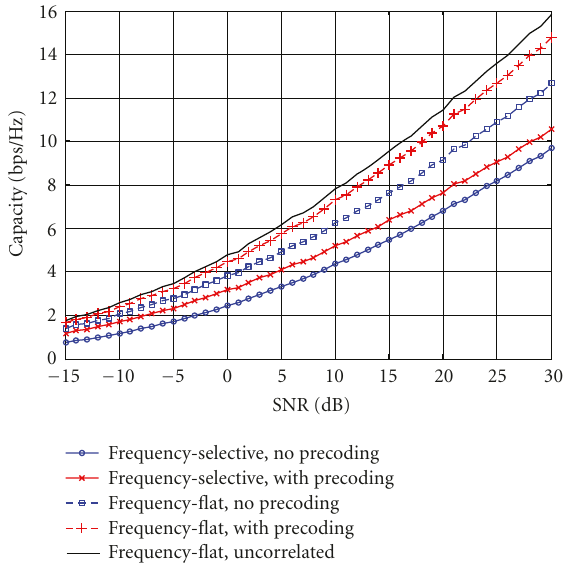
Figure 3: Performance comparison in partially correlated channels.